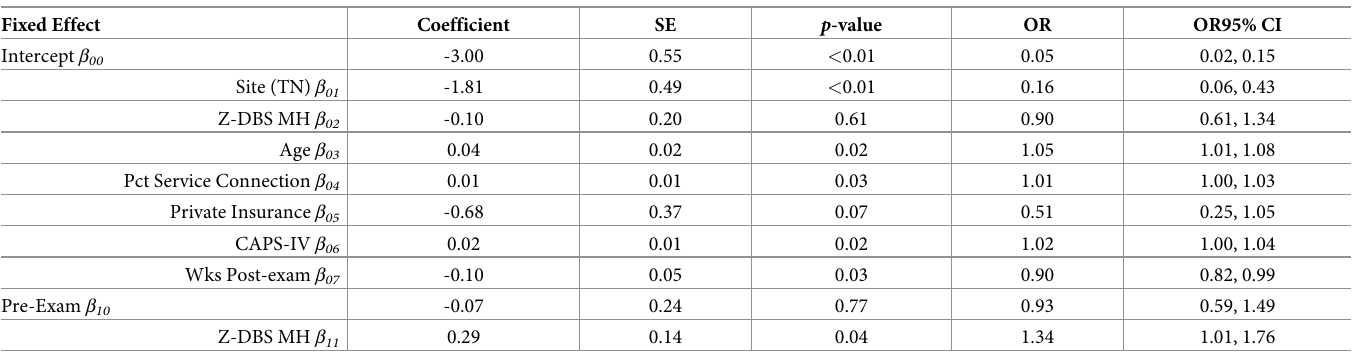
Table 3. Multilevel logistic regression of PTSD service use.